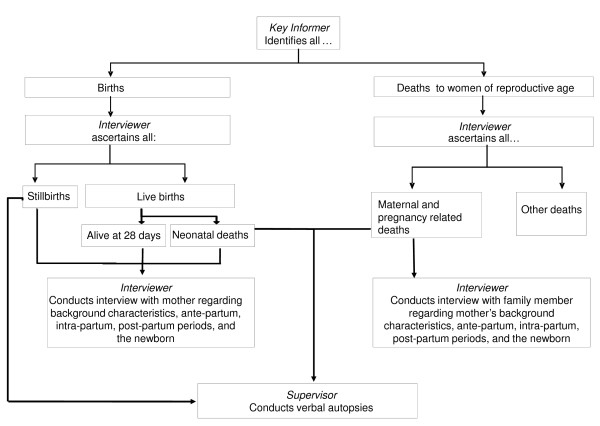
Surveillance system.